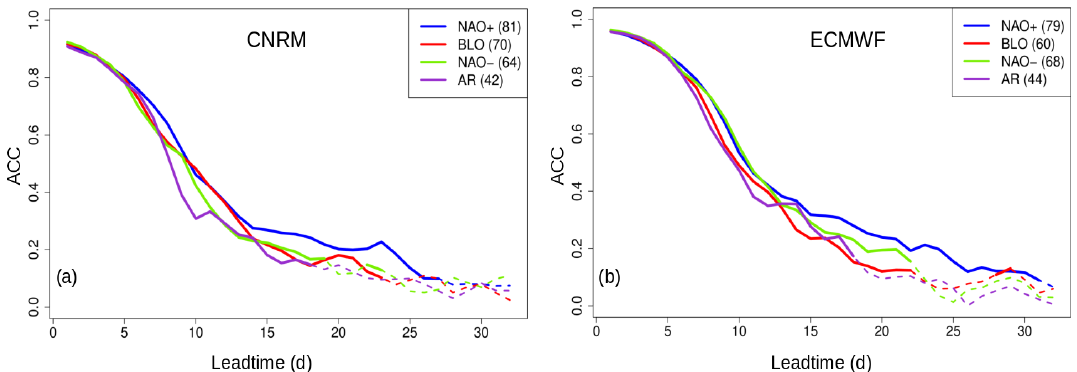
Figure B1. Like Fig. 5 but with a fifth category “none” including days outside any persistent sequence of a canonical weather regime.